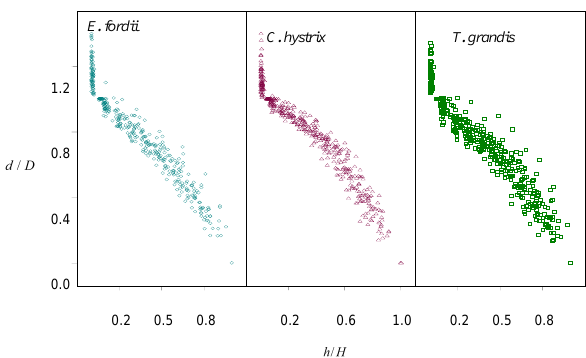
Figure 1. The scatter distribution of Erythrophleum fordii, Castanopsis hystrix and Tectona grandis.